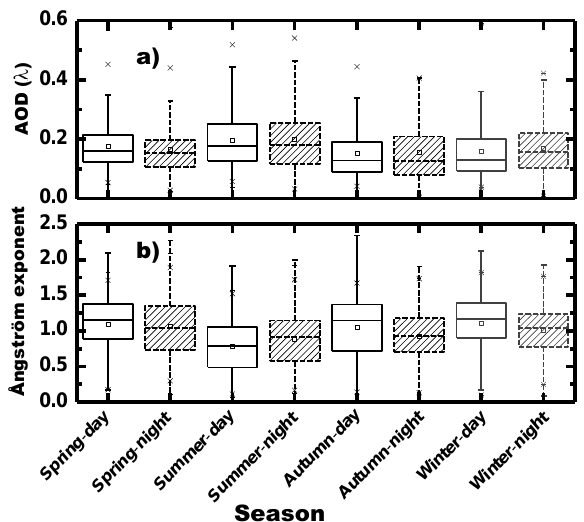
Fig. 5. Seasonal Box-Whisker diagrams of (a) AOD(440nm) and AOD(436nm) (b) α (440–870nm) and α (436–880nm) obtained at daytime and nighttime, respectively, during the period from 2007 to 2010 at the station of Granada. Dashed Box is for night-time data and empty Box is for day-time data. In these box diagrams the mean is represented by an open square. The line segment in the box is the median. The top limit represents the 75th percentile (P75) and the bottom limit the 25th percentile (P25). The box bars are related to the 1st (P1) and 99th (P99) percentiles, and the crosses represent the maximum and minimum values, respectively. The lines perpendicular to the box diagrams are 1.5 the interquartile range.